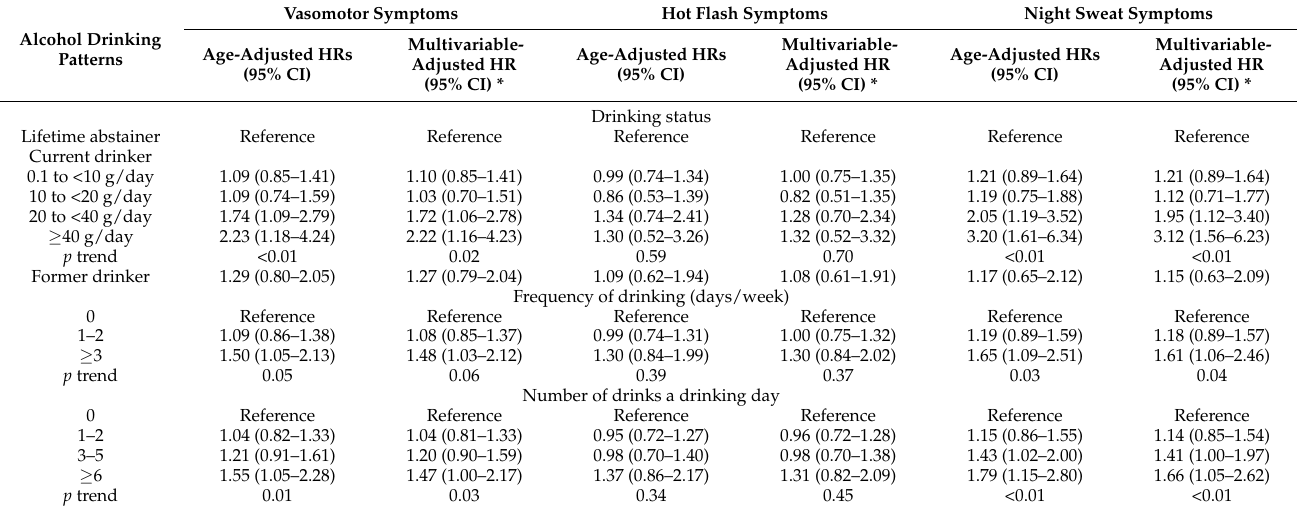
Table 3. Longitudinal association between alcohol consumption and incidence of early-onset, moderately-to-severely bothersome VMS (overall and each component including hot flash or night sweat) among premenopausal women ( n =